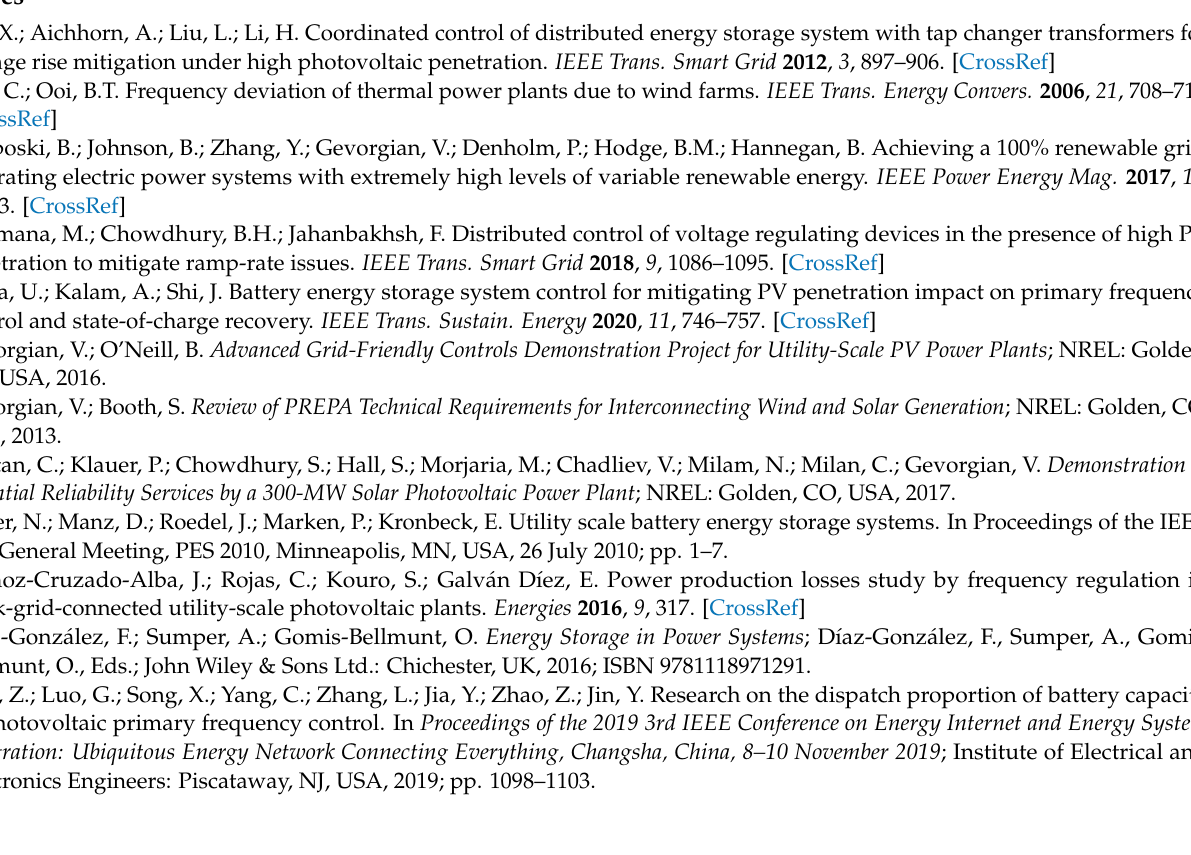
Table A1 shows that, despite the overall system’s efficiency decrease with the decrease in the battery round trip efficiency, the ranking of the three different layouts remains unchanged (1st DC/BESS, 2nd AC, and 3rd DC/PV). We report that percentage difference among efficiency values decrease with the decrease in the battery efficiency due to the lower value of η B compared to the PCS efficiency. The final efficiency is more weighted by the battery losses, and the sensitivity of the efficiency parameter as a function of the PCS layout decreases accordingly. Moreover, considering the average C-rate with which the battery works (0.08 C) may be possible to also assume η B around or higher than 98%, and the error introduced is less